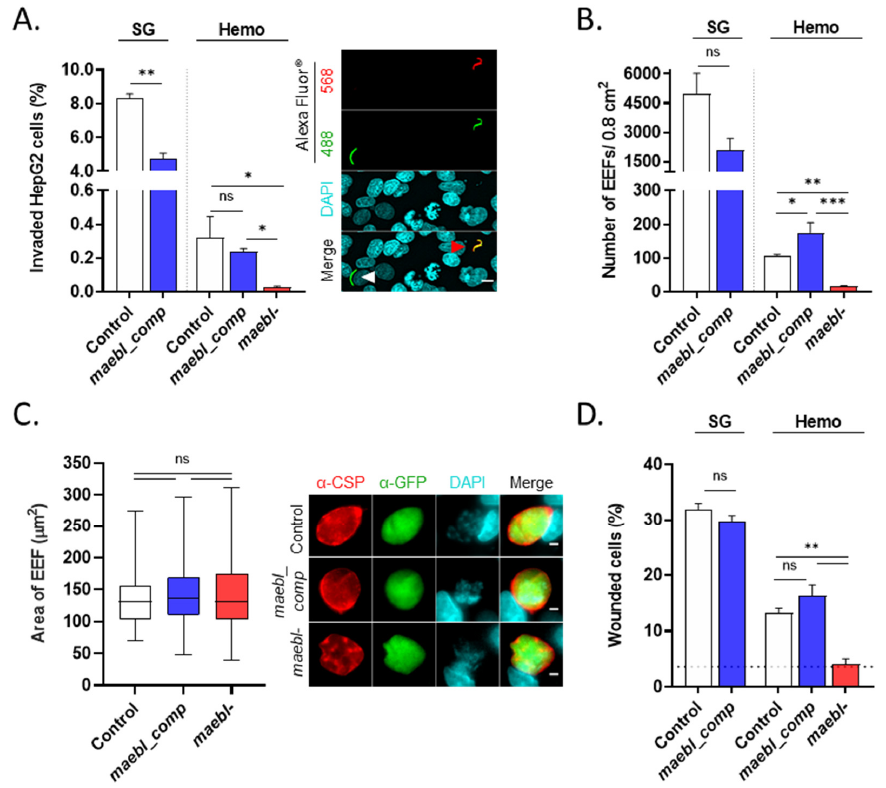
Figure 3. Evaluation of HepG2 cells invasion and cell wounding activity of maebl - sporozoites. ( A – C ) Invasion of cells by maebl - and maebl_comp sporozoites and exoerythrocytic forms (EEFs) development. Control, maebl - or maebl_comp hemolymph (Hemo) or salivary glands (SG) sporozoites, collected from mosquitoes on days 19 to 21 post-infection, were incubated with cells for 2 h (panel A ) or 48 h (panel B , C ). ( A ) Left : percentage of cells containing intracellular sporozoites. Bars represent the mean + SD of experimental replicates. Statistical analysis was performed using unpaired t -test (SG) or one-way ANOVA (Tukey’s multiple comparisons test; Hemo). Right : representative immunofluorescence images of intracellular (white arrow) and extracellular sporozoites (red arrow). DAPI-stained cell nuclei, cyan. Scale bar, 10 µ m. ( B ) Number of EEFs in cells per well. Bars represent the mean + SD of experimental replicates. Values are representative of at least two independent experiments (panel A , B ). Statistical analysis was performed using unpaired t -test (SG) or one-way ANOVA (Tukey’s multiple comparisons test; Hemo). ( C ) Left : area of EEFs. Box plots showing the median, maximum, minimum, and the 25th and 75th percentiles of the area of individual EEFs. At least 45 EEFs were analyzed